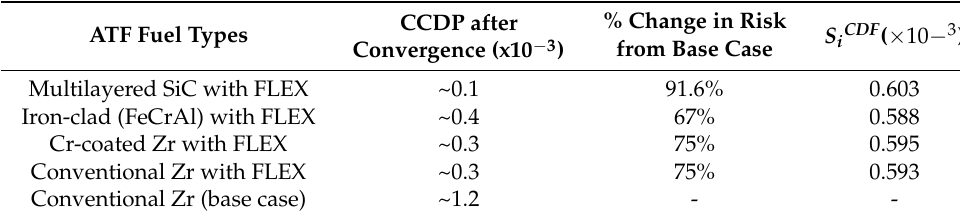
Table 7. Benefit index of FLEX with different fuel